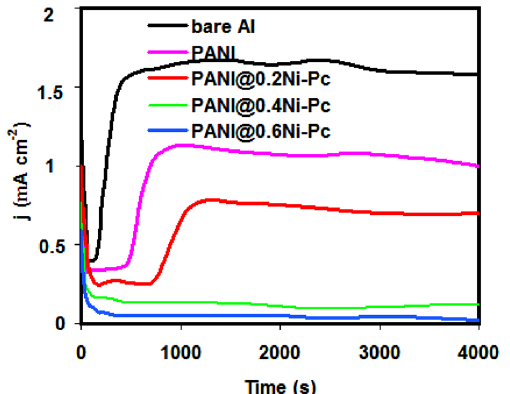
Figure 3. CA curves for pristine Al foil and coated Al foil with pristine PANI and PANI@Ni-Pc composites in LiN(SO